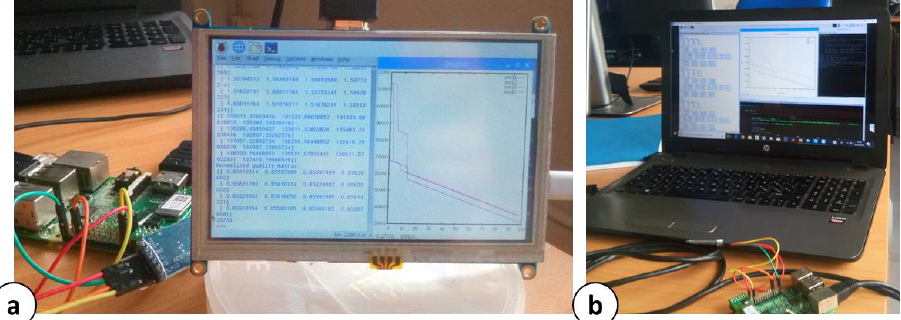
Figure 9. Snapshots of Central Control Unit possible setups: ( a ) Local Interface through 7″ LCD ( b ) Dedicated interface on a personal computer through Ethernet connection.